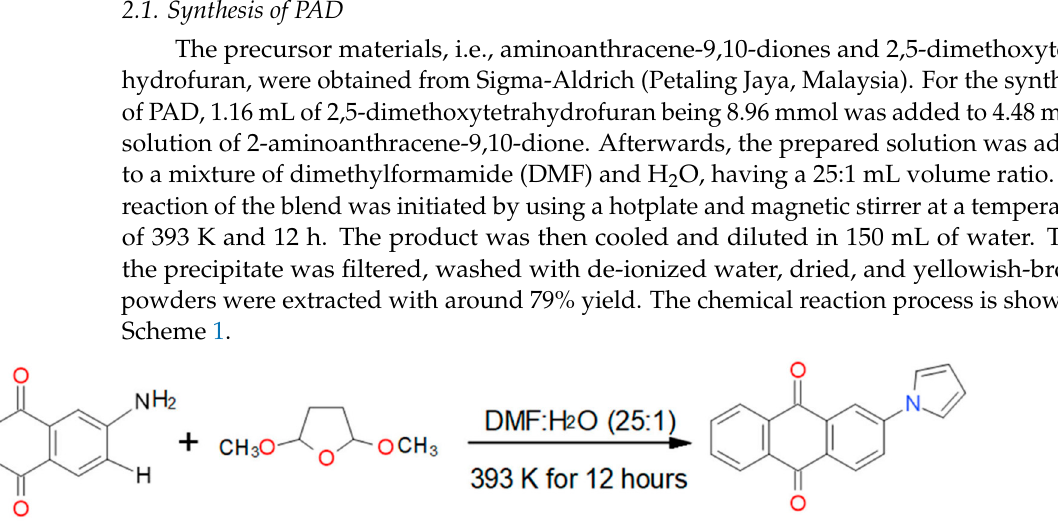
Scheme 1. Synthesis reaction of PAD.